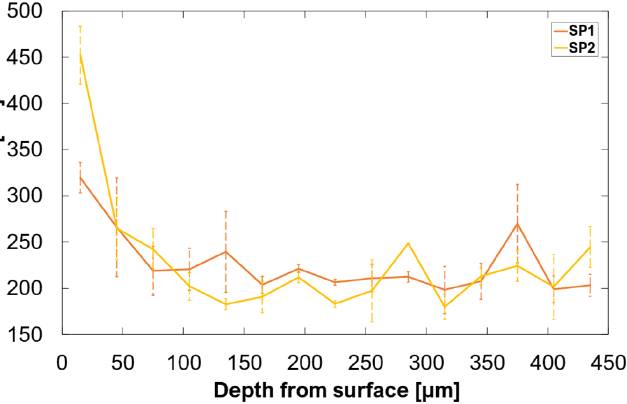
Figure 5. Cross-section hardness variation as a function of depth of SP1 and SP2 conditions.